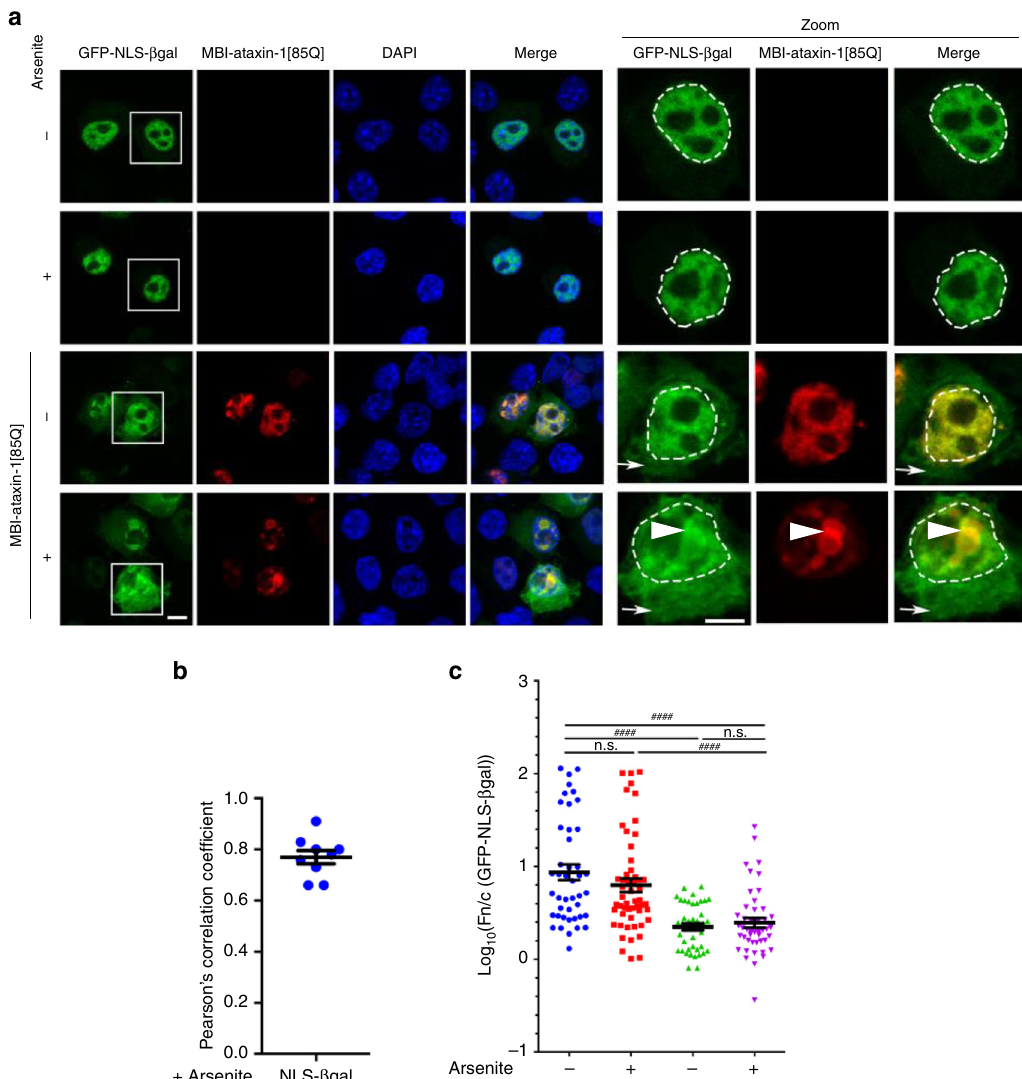
Fig. 4 Ataxin-1[85Q] reduces nuclear accumulation of a conventional importin- α / β 1-cargo. Neuro-2a cells were cotransfected to express MBI-ataxin-1 [85Q] together with GFP-TagNLS- β -galactosidase (GFP-NLS- β Gal). At 24 h post-transfection, cells were treated with arsenite as indicated, and then fi xed, stained with anti-myc antibody and DAPI, before CLSM imaging. a Representative images are shown; merge panels overlay GFP, myc, and DAPI images. Zoom images (right panels) correspond to the boxed regions. The position of the nucleus, as determined by DAPI staining, is indicated by the white dashed lines; white arrows denote increased cytoplasmic fl uorescence in the presence of MBI-ataxin-1[85Q]. Scale bar = 10 μ m. b Pearson ’ s correlation coef fi cients, calculated using the coloc2 plugin for localisation between fl uorophores in a 25 μ m 2 square centred over each arsenite-induced ataxin-1 nuclear body, quantitatively assessed co-localisation of GFP-NLS- β gal with ataxin-1 nuclear bodies, where 0 indicates no correlation between two channels whereas 1 indicates complete correlation of two channels. Results represent the mean ± SEM ( n = 9 cells imaged across three independent experiments). c Integrated fl uorescence intensity in nucleus and cytoplasm was estimated and the nuclear to cytoplasmic fl uorescence ratio (Fn/c) determined using a modi fi ed CellPro fi ler pipeline. Results represent the mean log 10 Fn/c ± SEM calculated across three independent experiments using the following numbers of analysed cells: -arsenite/-ataxin-1[85Q] n = 44, + arsenite/-ataxin-1[85Q] n = 53, -arsenite/ + ataxin-1[85Q] = 43, + arsenite/ + ataxin-1[85Q] n = 46, p value from top to bottom and left to right: p < 0.00001, p < 0.00001, p > 0.99999, p > 0.99999, p = 0.00005 ( #### p < 0.0001, n.s. not signi fi cant, Mann – Whitney and Kruskal – Wallis non-parametric test). Source data are provided as a Source Data fi